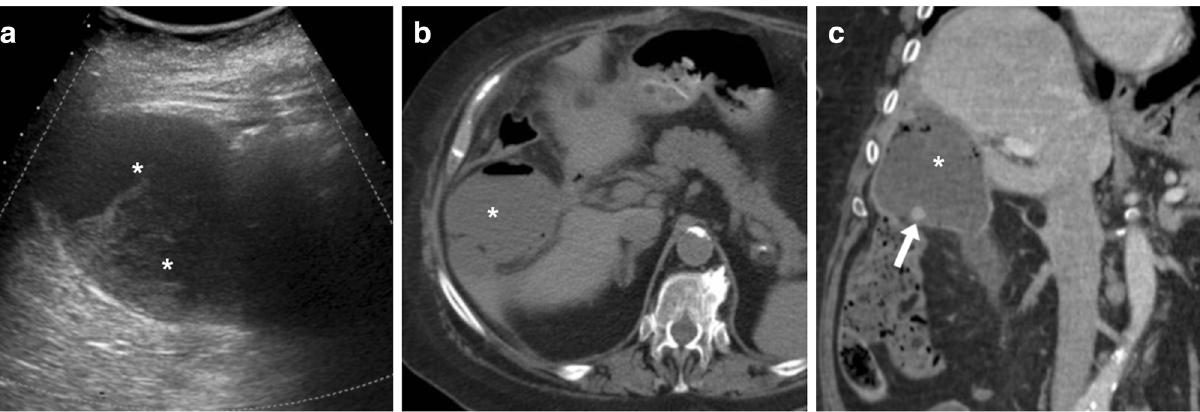
surgical bed, with predominantly fluid content, non-dependent air and thin enhancing peripheral wall. The faintly calcific fragment ( arrow in c ) corresponded toa dropped gallstone. PercutaneousCT-guideddrainage was required to relieve extended-spectrum beta-lactamase-producing (ESBL+) Escherichia coli infection. (Partially reproduced from Open Access ref.